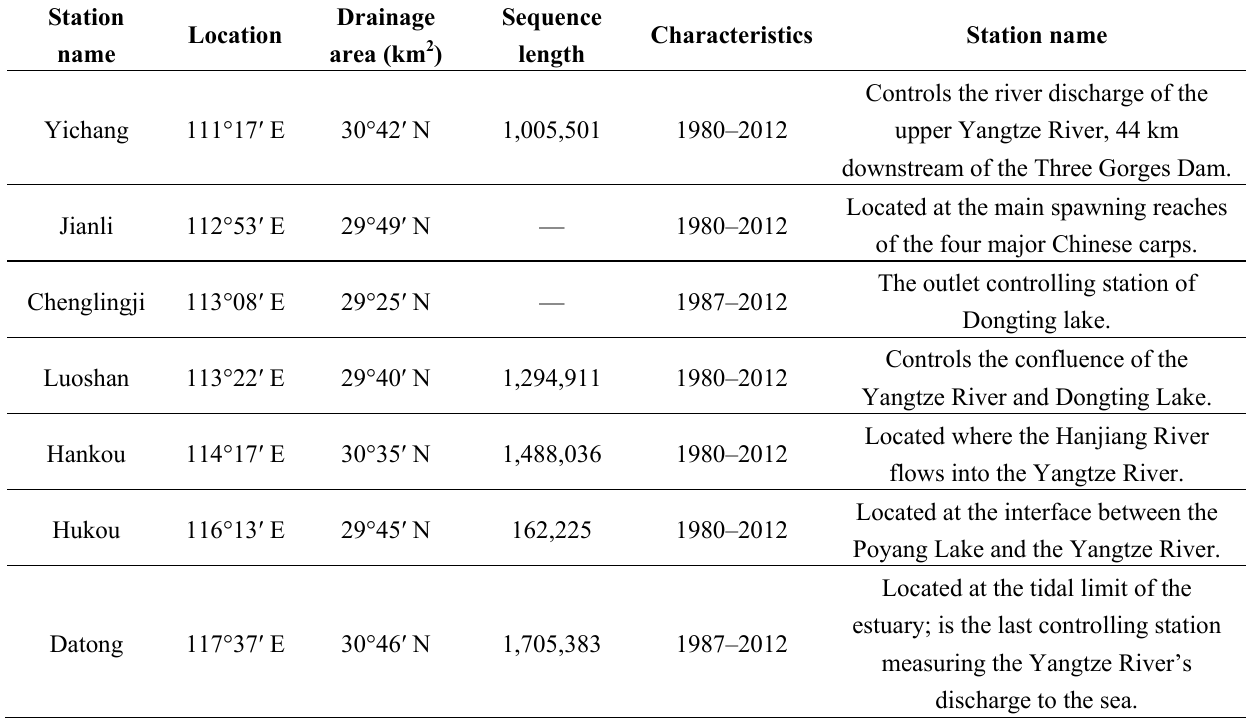
Table 1. Detailed information of the hydrological stations in the middle and lower Yangtze